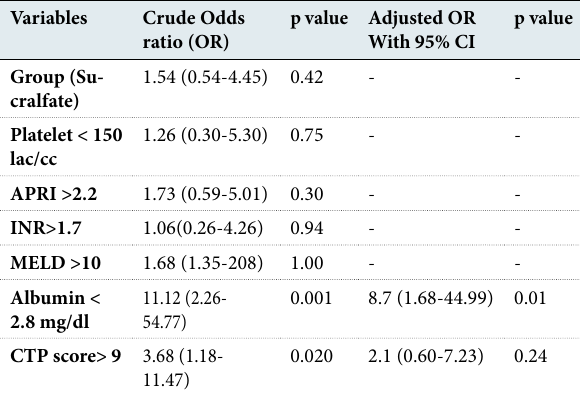
Table 3: Bi-variate and multivariate analysis for the formation of multiple (>2) ulcers